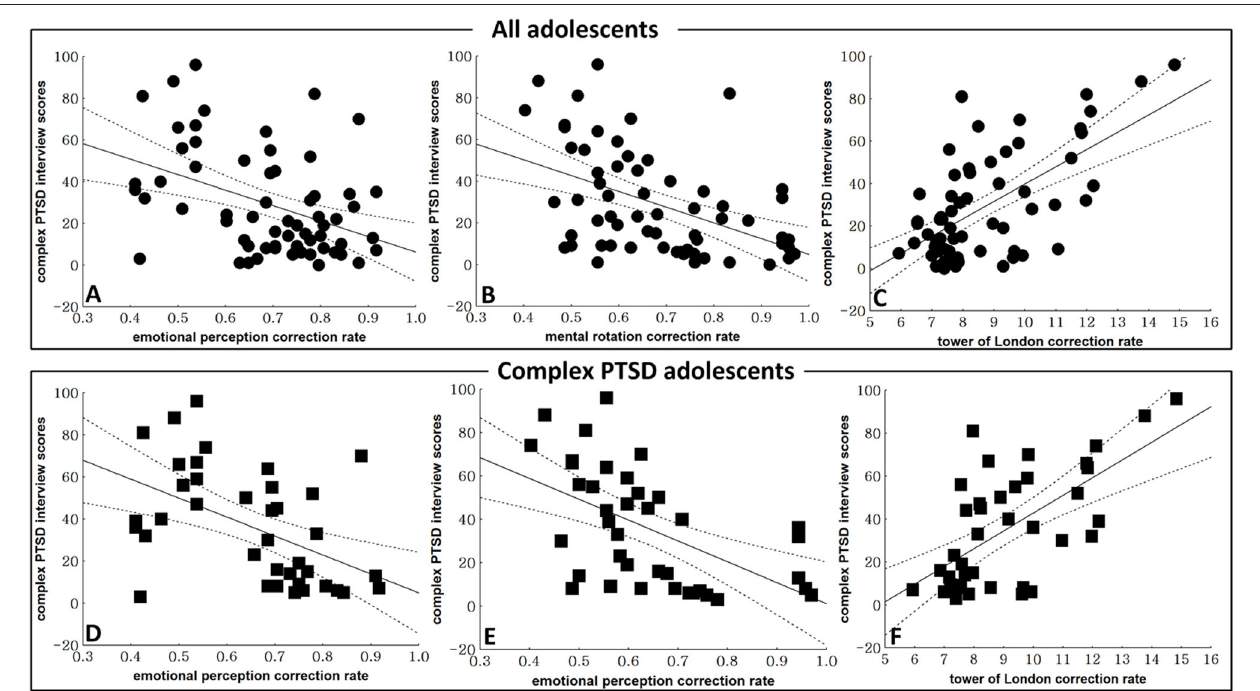
FIGURE 2 | Correlations between C-PTSD symptoms and neurocognitive function test results. (A) The correlation between total complex post-traumatic stress disorder (C-PTSD) Interview Scale scores and the accuracy rate in the emotional test ( r = − 0.414, p = 0.001) in all adolescents (C-PTSD and PTSD groups). (B) The correlation between the total C-PTSD Interview Scale and the accuracy rate in the mental rotation test ( r = − 0.468, p < 0.001) in all adolescents. (C) The correlation between the total C-PTSD Interview Scale and the number of moved cards in the modified Tower of London test ( r = 0.631, p < 0.001) in all adolescents. (D) The correlation between the total C-PTSD Interview Scale scores and the accuracy rate in the emotional test ( r = − 0.497, p = 0.001) in the C-PTSD group. (E) The correlation between total C-PTSD Interview Scale scores and the accuracy rate in the mental rotation test ( r = − 0.542, p < 0.001) in the C-PTSD group. (F) The correlation between the total C-PTSD Interview Scale scores and the number of moved cards in the modified Tower of London test ( r = 0.636, p < 0.001) in the C-PTSD